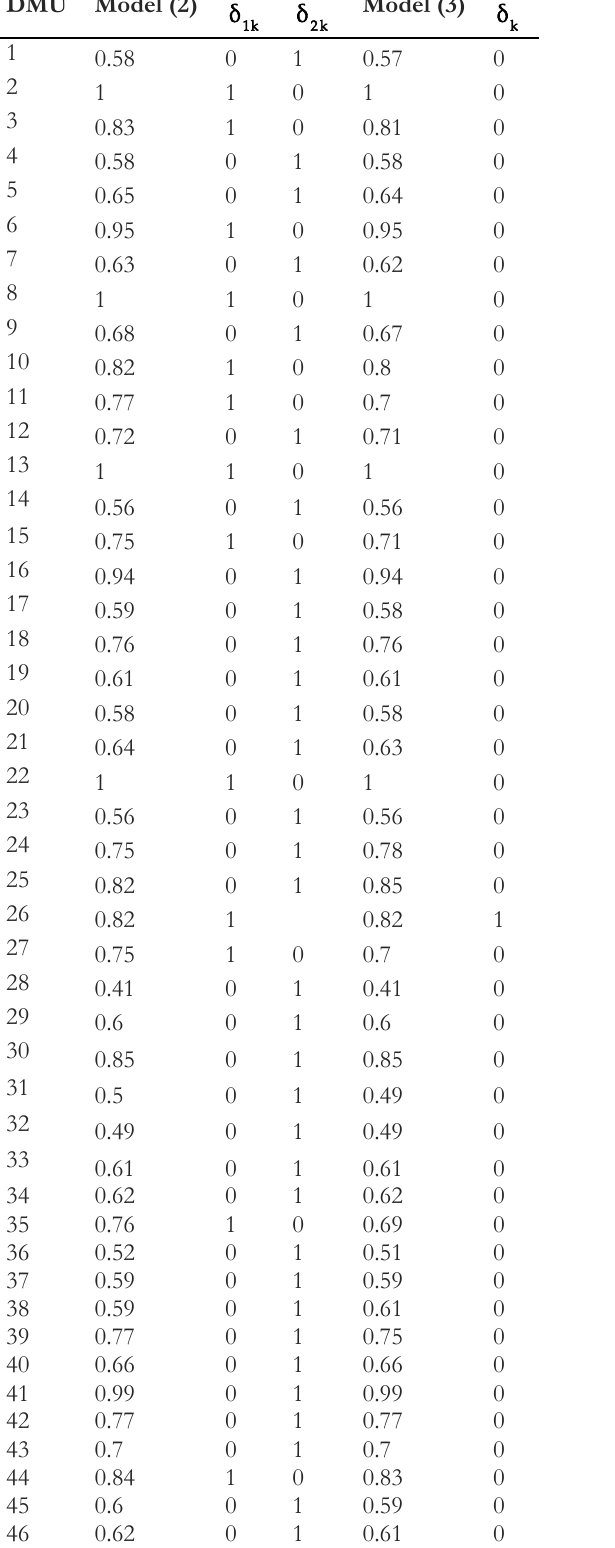
Table 3. Efficiency with flexible